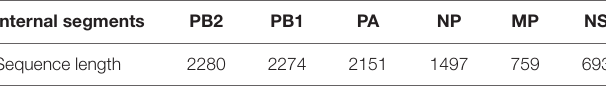
TABLE 1 | Lower threshold for internal segments nucleotide sequence